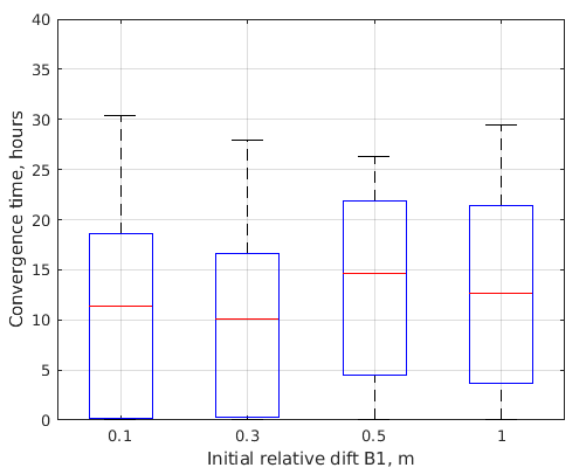
B . Figure 13. Convergence time depending on initial drift B 1 1